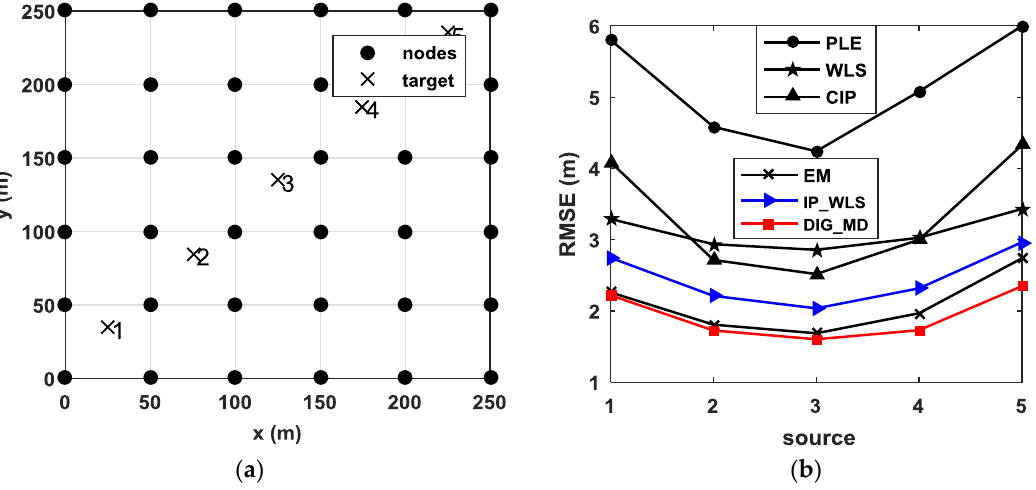
Figure 9. ( a ) Five target positions in a 36-node distributed network; ( b ) RMSE for different target positions when m = 4, u = 5, σ 1 = 2 ◦ and σ 2 = 15 ◦